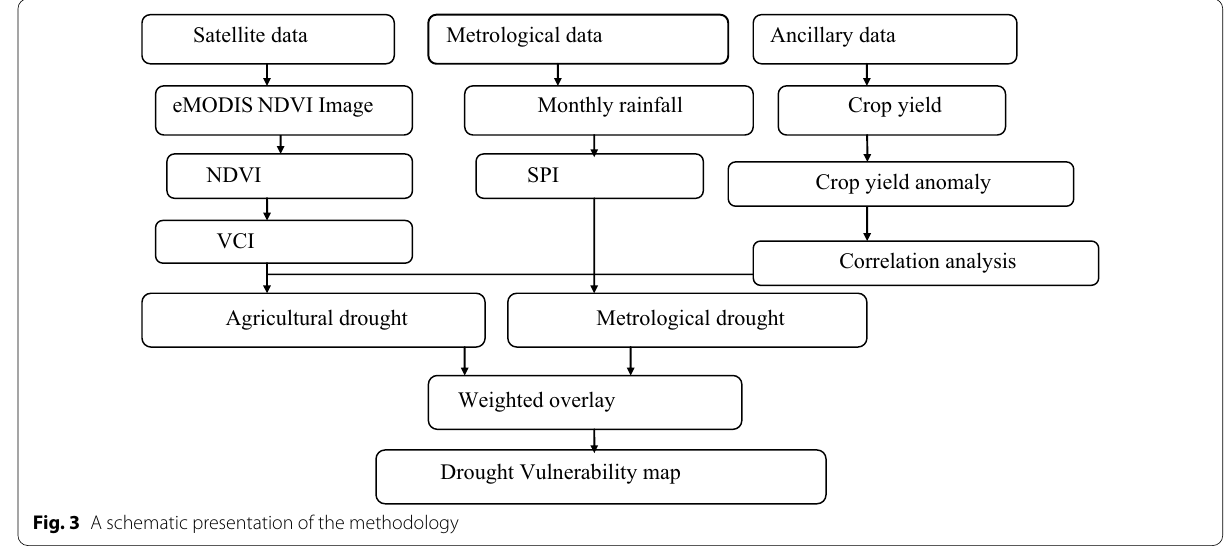
Fig. 3 A schematic presentation of the methodology